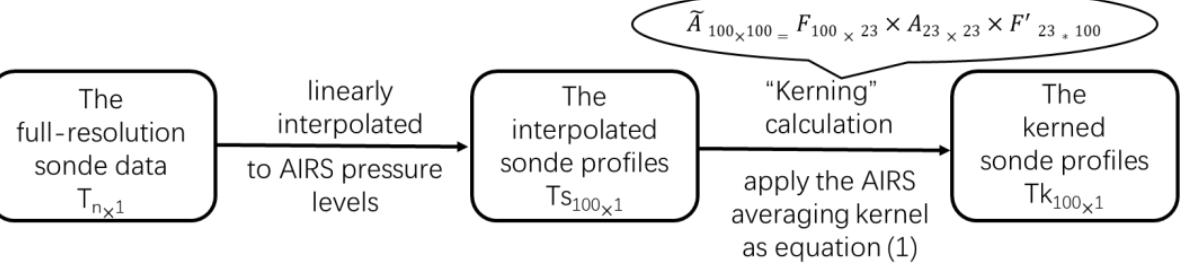
Figure 2. Flowchart of the producing the kerned sonde profiles using the AIRS averaging kernel. The retrievals are evaluated using four parameters: the mean bias ( MB ), standard deviation ( σ ), root mean square error ( RMSE ), and correlation coefficient (R), which are elaborated below.